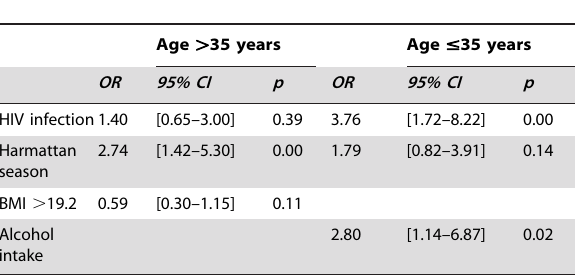
Table 2. Adjusted multivariable logistic regression analyses of correlates of NTM infection by age group among